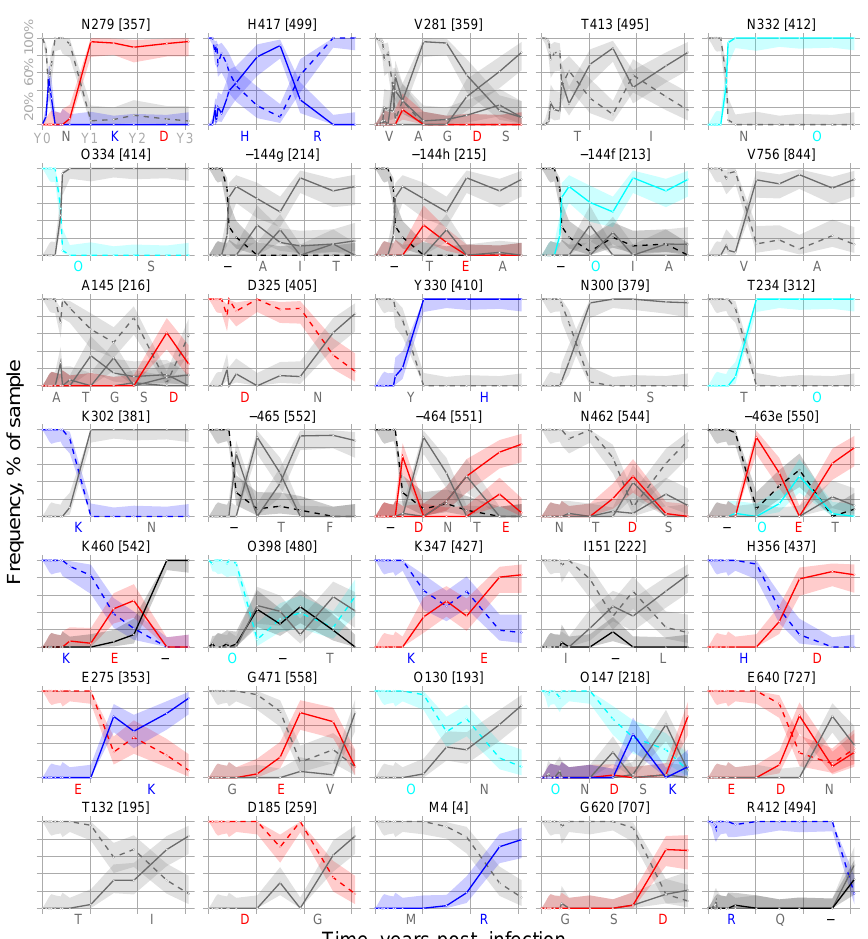
Figure 2. Variant frequency dynamics within sites. The single TF virus amino acid (dashed lines with 100% initial frequency) yields to putative escape mutations (solid lines with 0% initial frequency) over the sampling period. Letters below each plot list mutations in order of appearance, with panels ordered by timing of TF loss. Numbers above each plot denote TF form, HXB2 position, and alignment column, e.g., “N279 [357] indicates loss of the transmitted asparagine at HXB2 position 279, alignment column 357. Lower-case letters denote insertions at the C-terminal end of the HXB2 site given. Colors indicate positive (blue) and negative (red) charges and an “O” is used instead of “N” to indicate a potentially glycosylated asparagine (cyan), i.e. , an N that is embedded in a glycosylation motif of Nx[ST], where x can be any amino acid except Pro, followed by either Ser or Thr. Vertical bars indicate the sampling year, abbreviated in the upper left panel as Y0, Y1 and Y2, with a single TF virus starting at Y0, then followed by the first time-point sampled, estimated to be 28 days post infection for CH505 [15]. Shaded regions show 95% confidence intervals for variant frequencies, computed from the binomial probability distribution, given the number of sequences sampled per time-point. Several distinct insertions arise after HXB2 position 144 in the V1 loop, shown in panels in the middle of the second row as 144f, 144g, and 144h. Lower-case letters (f through h) specify the relative positions of the inserted region in the alignment [45]. The TF lacks an amino acid in this position, which is characterized as a gapped state and represented by a dash (–) to maintain the alignment. Over time, new and distinct insertions arise that span this position, with major and minor variants carried along with distinctive insertions occurring at positions 144f, 144g, and 144h (e.g., in 144 g, three different insertions are maintained, which include A, I and T).